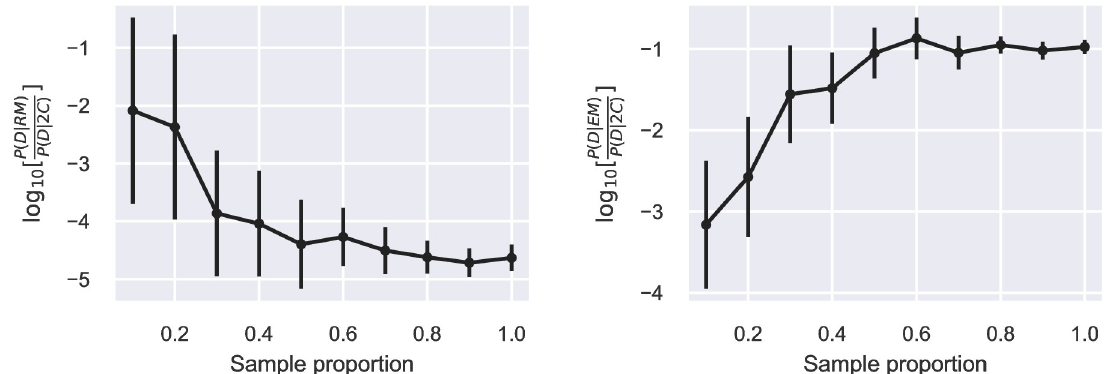
Fig 2. Convergence of Bayes factors for the Fokkens_1a dataset. Bayes factors were estimated based on 20,000 NUTS samples for the 2C model and 60,000 NUTS samples for the RM and EM models. The error bars are standard deviations estimated by 1000 bootstrapping samples. Similar plots for the 10 other datasets are shown in the Supporting Information (S3 to S12 Figs).